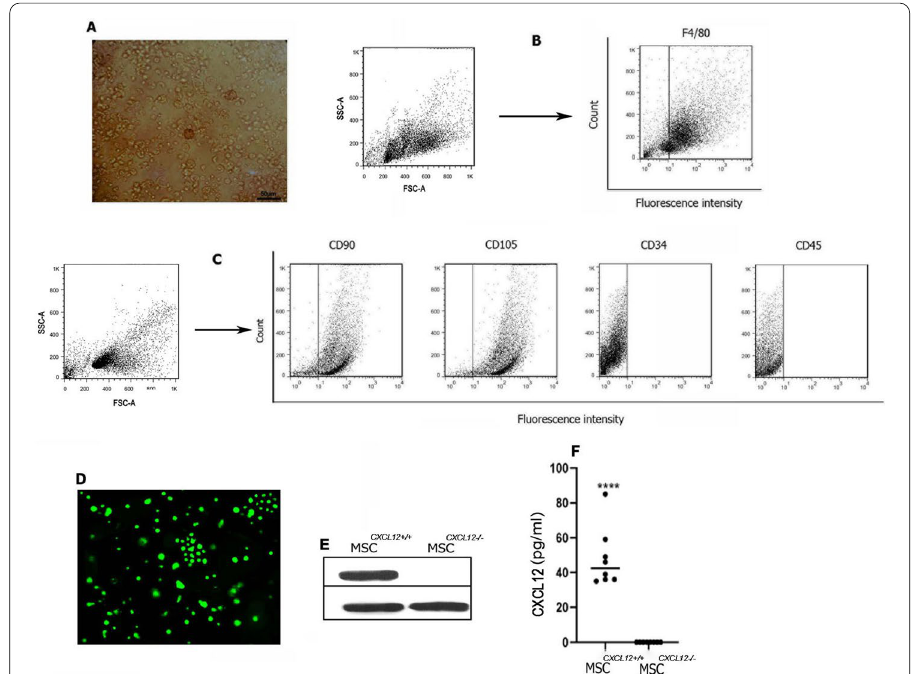
Fig. 1 Cell characteristics of bone marrow derived macrophages (BMDMs) and mesenchymal stem cells (MSCs). Phase contrast microscopic image of BMDMs 5 days after in vitro culture ( A ). Flow cytometric analysis of BMDMs for F4/80 ( B ). Flow cytometric analysis of MSCs for CD90, CD105, CD34, and CD45 ( C ). CXCL12 gene knockout in MSCs. Transfection of MSCs with a GFP‑positive CRISPR/Cas9 plasmid to knock out CXCL12 gene ( D ). Western blotting for knockout efficiency ( E ). β‑actin was used as a control. CXCL12 measurement in the serum‑free conditioned media of MSC CXCL12+/+ and MSC CXCL12-/- by ELISA ( F ). Each point indicates an experiment (horizontal lines: